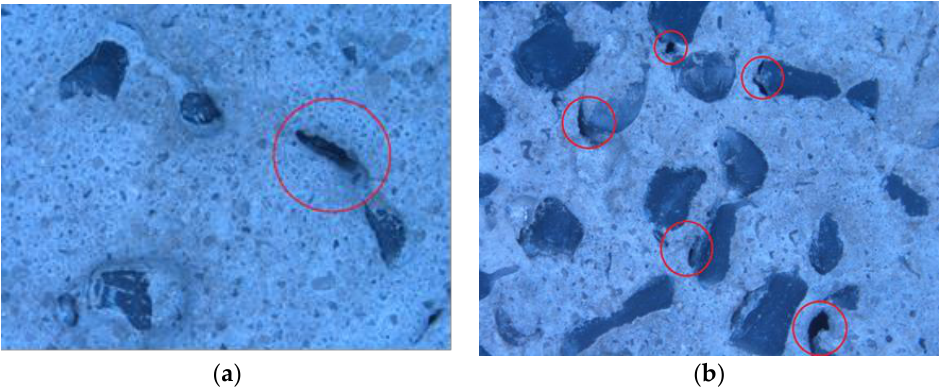
Figure 10. Optical microscope images of the prepared samples (a) with 20% rPP replacement and (b) with 50% rPP replacement.